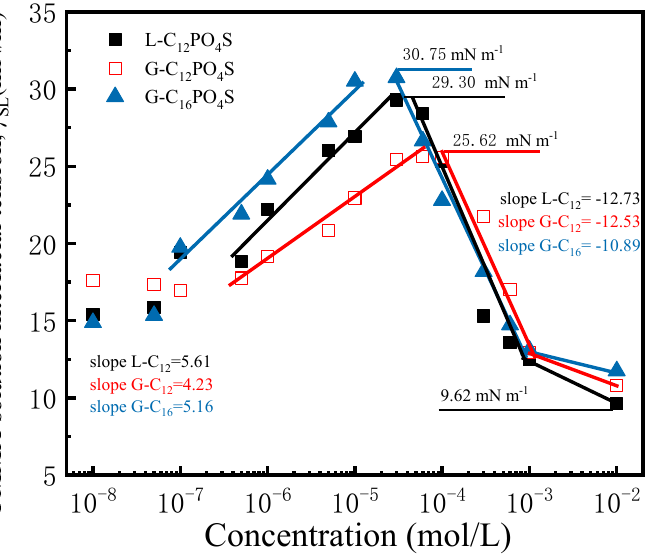
Figure 4. The PMMA–solution interfacial tension as a function of surfactant concentration. Table 3. The surface activity parameters of the extended surfactants at PMMA. Table 3. The surface activity parameters of the extended surfactants at PMMA.